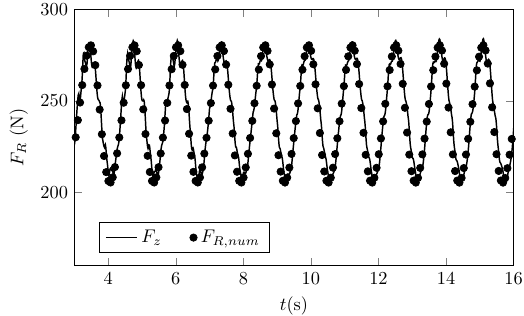
Figure 3. Comparison between numerical and fitted radiated force for floater 5 at T = 1.29